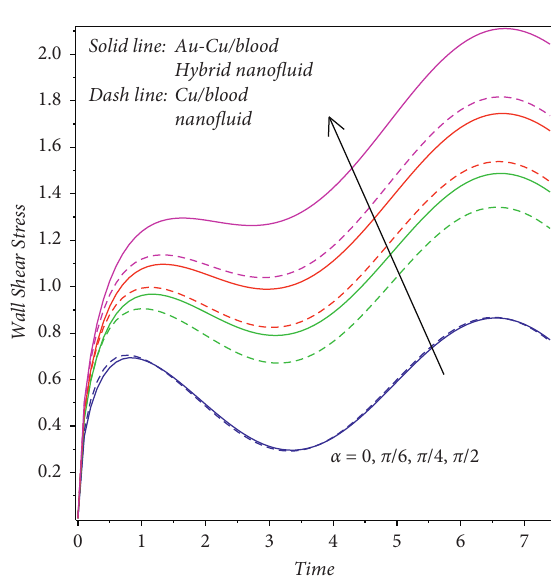
Figure 21: Behaviour of α on τ